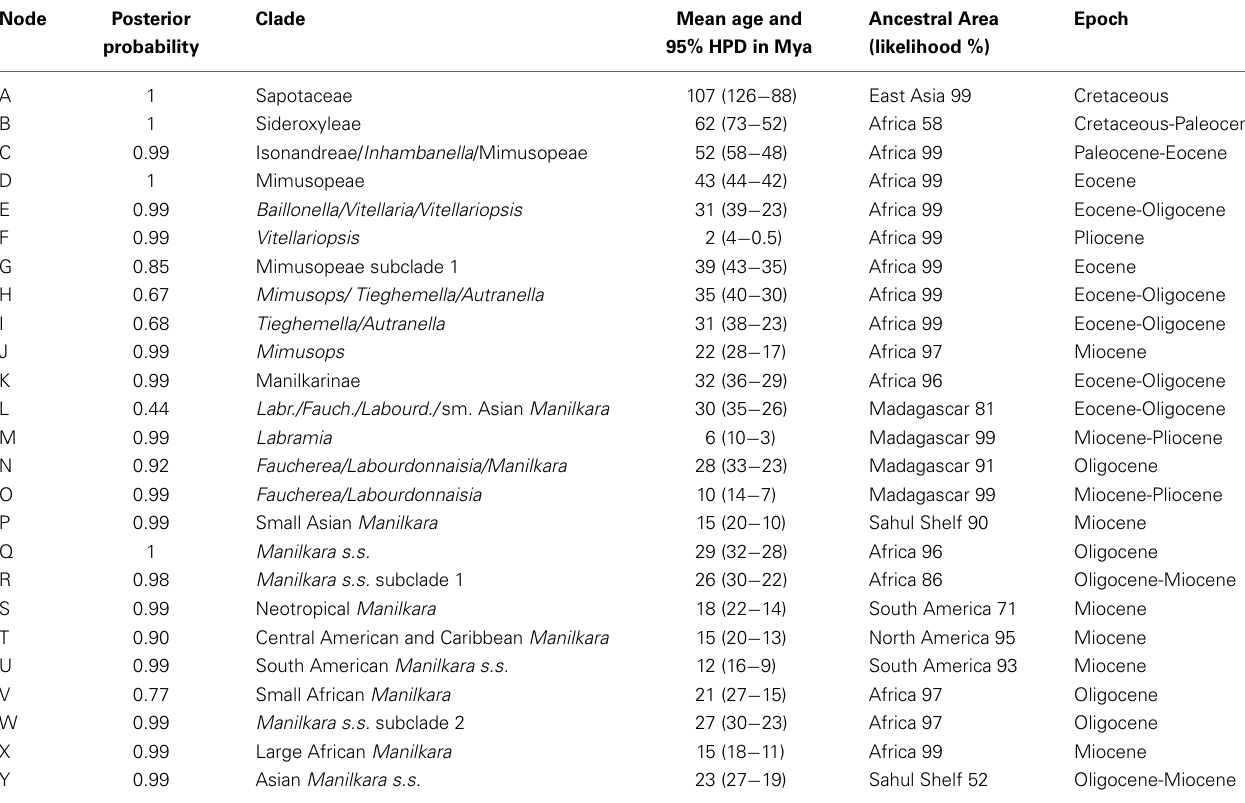
Table 1 | Summary of clade support values, node ages and ancestral areas from Figure 1. Node